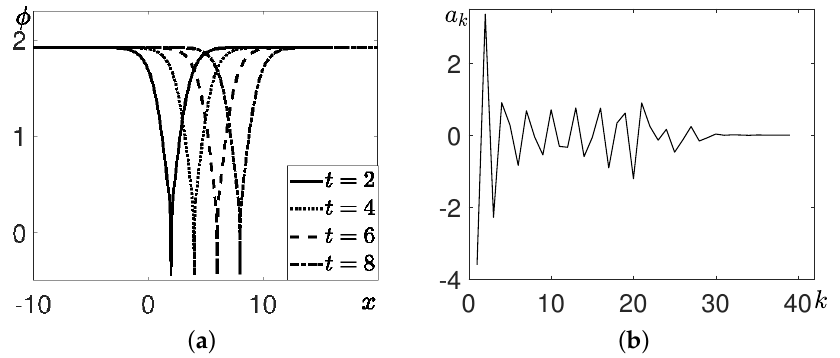
Figure 3. The parameters are chosen as in Figure 1b. ( a ) The series solution in (120) for the homoclinic orbit in Figure 1b. The solution is drawn as a function of x for different values of t , showing the traveling-wave nature of the obtained front solution. ( b ) The chosen value a 1 = − 3.4558, solution of the continuity Equation (118) truncated at M = 40, leads to convergent series coefficients a k . The series coefficient b k = a k are not